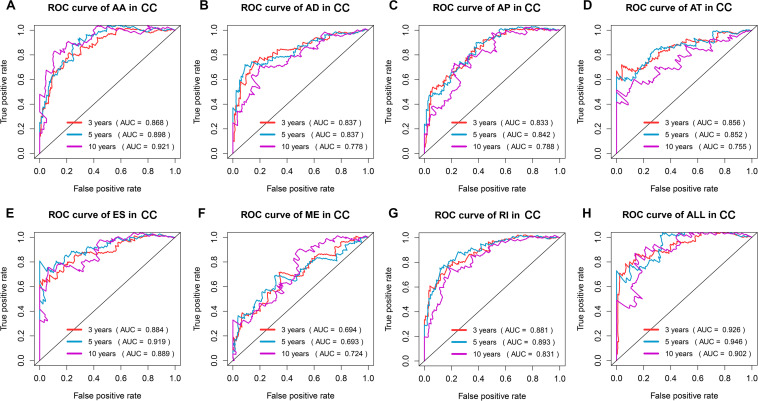
ROC curves with AUCs of prognostic predictor constructed with single type or seven types of AS events in CC patients, respectively. Red line represents 3 years, cyan line represents 5 years, and purple line represents 10 years.